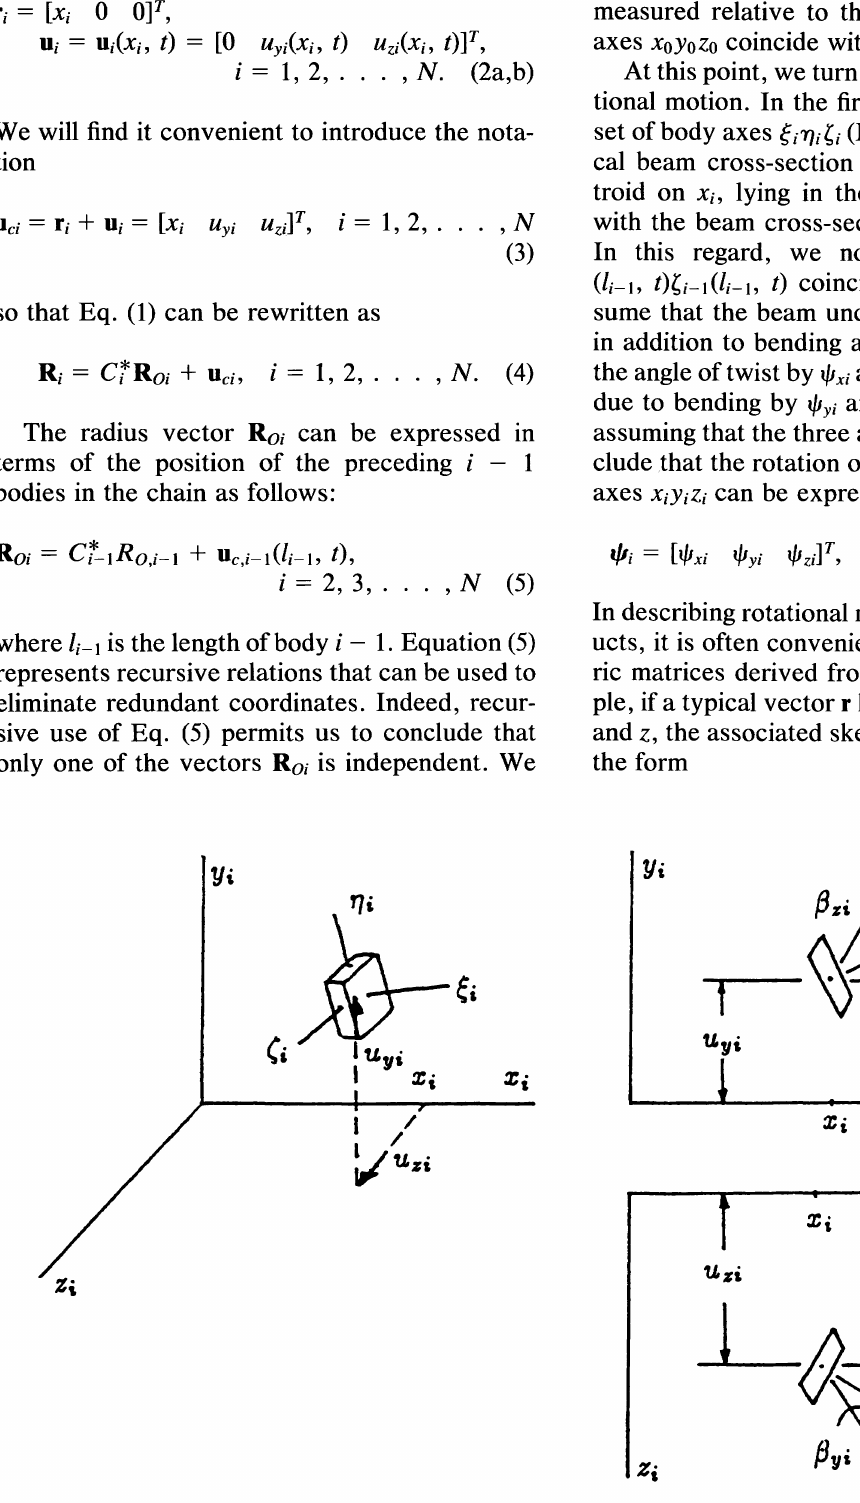
FIGURE 2 Bending